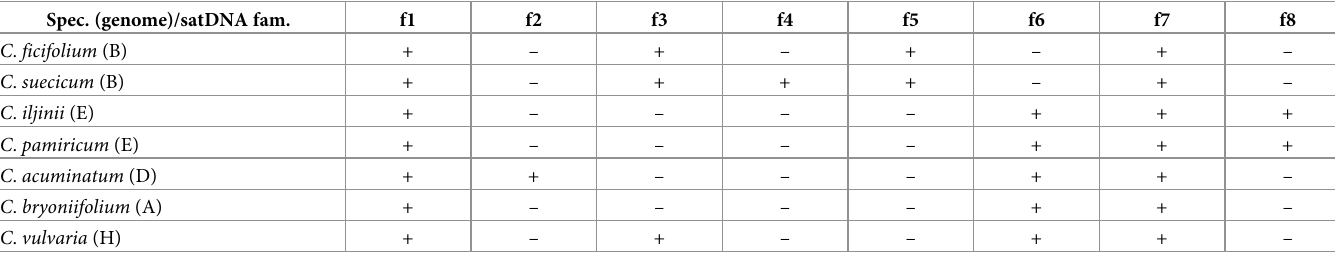
Table 3. Occurrence of specific satDNA families in the genomes of diploid C . album aggregate species. Spec. (genome)/satDNA